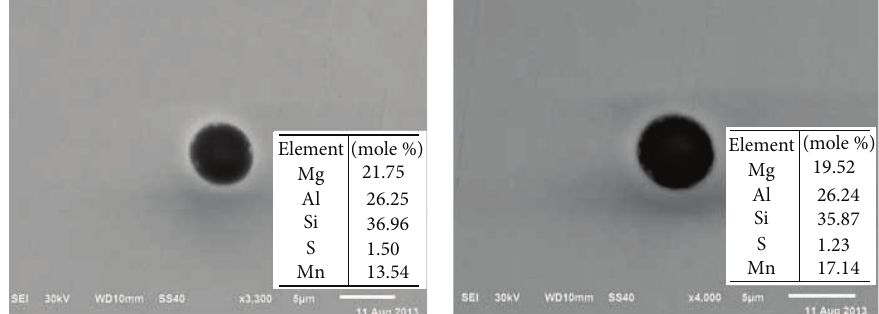
Figure 1: SEM micrographs and EDS results for typical magnesia-bearing oxide.